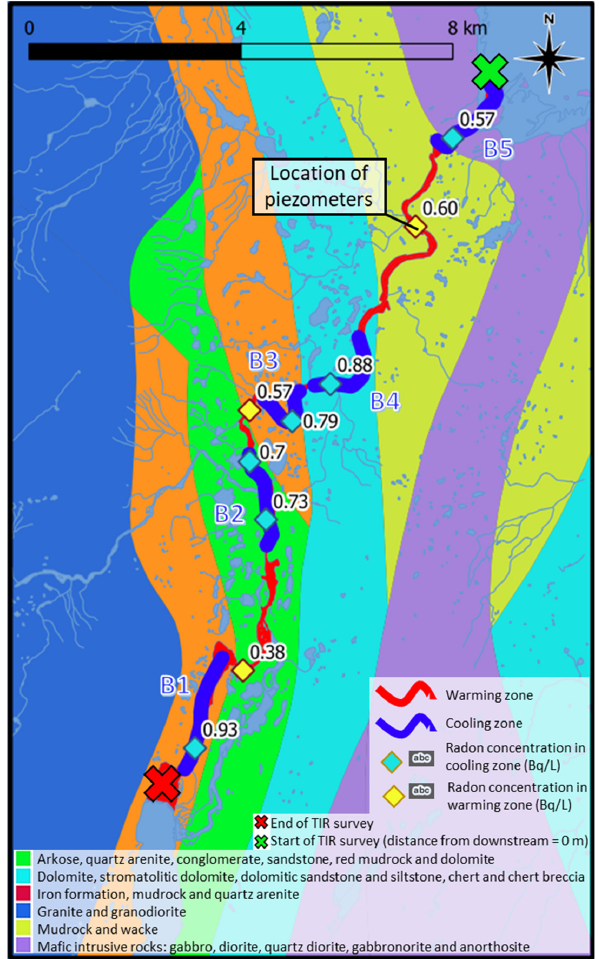
Water 2023 , 15 , x FOR PEER REVIEW Figure 9. Cooling zones and radon sampling points of Berard River. Figure 9. Cooling zones and radon sampling points of Berard River.